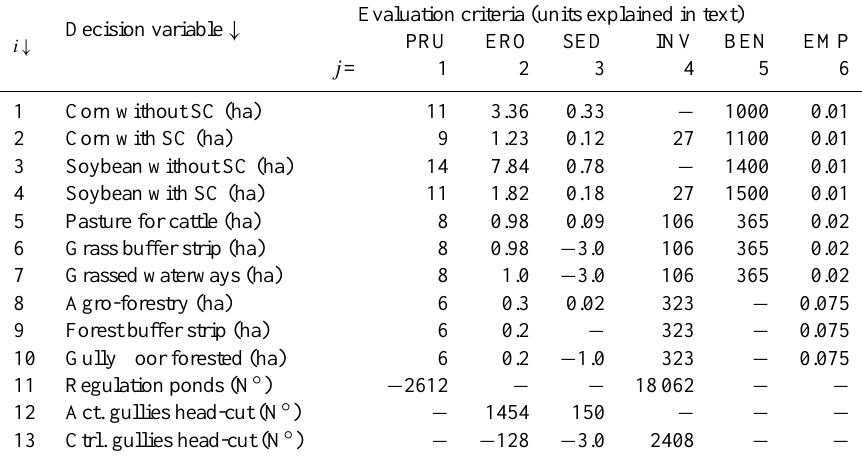
Table 1. Technical Equations matrix TE ij = a ij for La Colacha basin. Evaluation criteria (units explained in Decision variable ↓